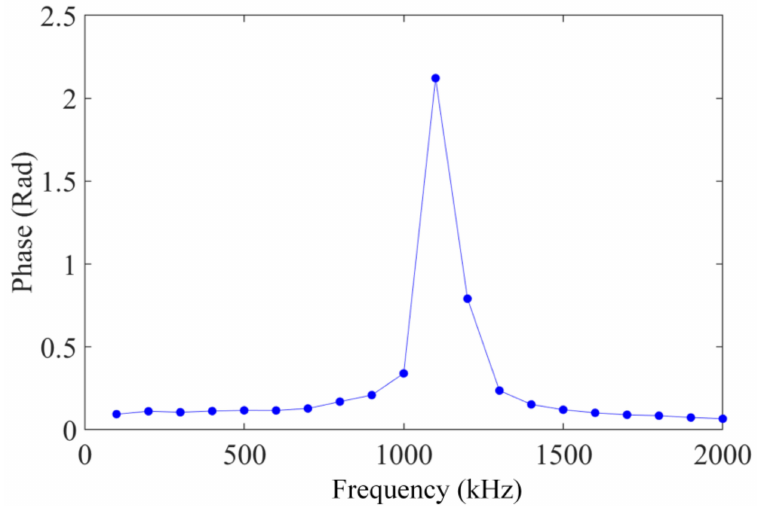
Figure 7. The relationship between excitation frequency and the output of the